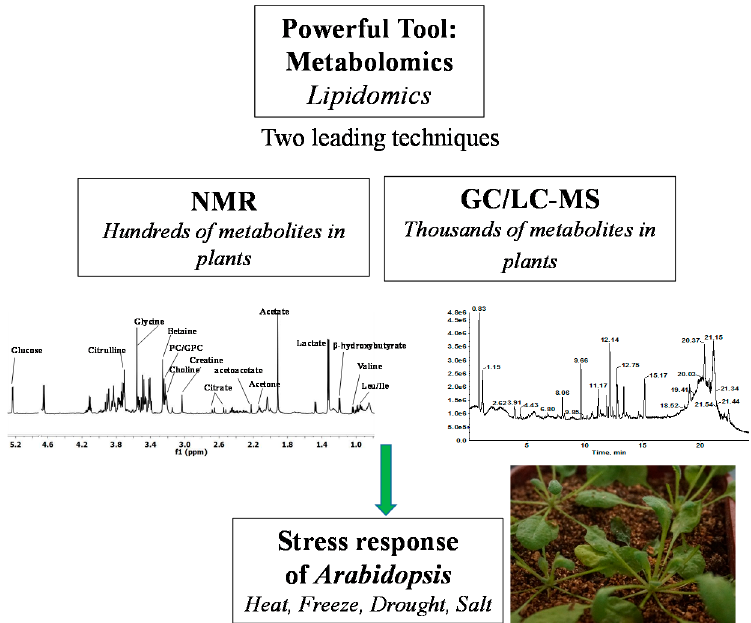
Figure 1. Two leading techniques, nuclear magnetic resonance (NMR) and gas chromatography/liquid chromatography–mass spectrometry (GC/LC-MS), and their applications to the elucidation of the physiological mechanisms of Arabidopsis to various environmental stressors.